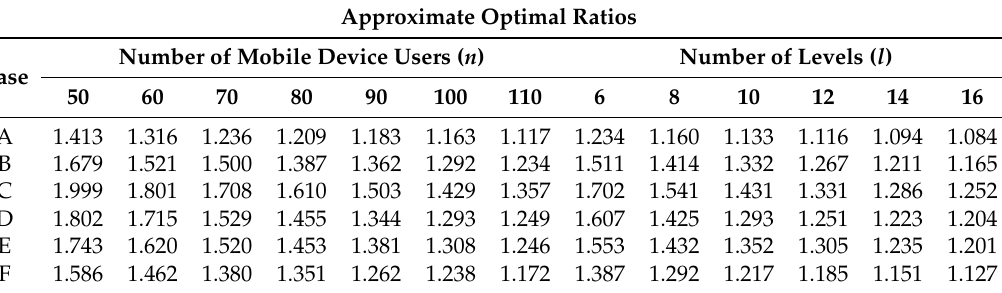
Table 3. The approximate optimal ratios under different